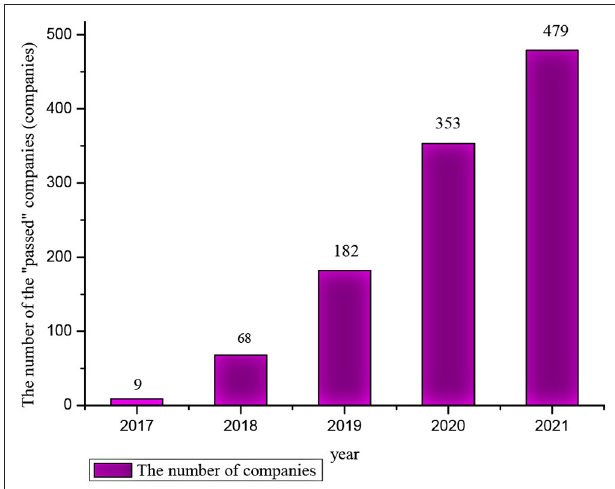
FIGURE 1 | The number of companies that pass the consistency evaluation each year (including “deemed to pass”). “Deemed to pass”: In addition to the generic drugs that have passed the consistency evaluation, it also includes generic drugs marketed in Europe, America, and Japan, and generic drugs marketed according to the original registration classification that meets the requirements of the consistency evaluation ( 11) (Data from “Chinese List of Chemical Drugs,”